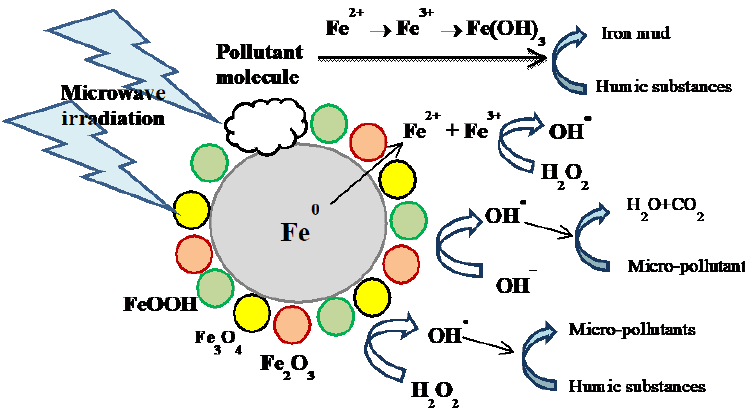
Figure 5. Typical microwave (MW)-ZVI-Fenton system. Reproduced with permission from Reference